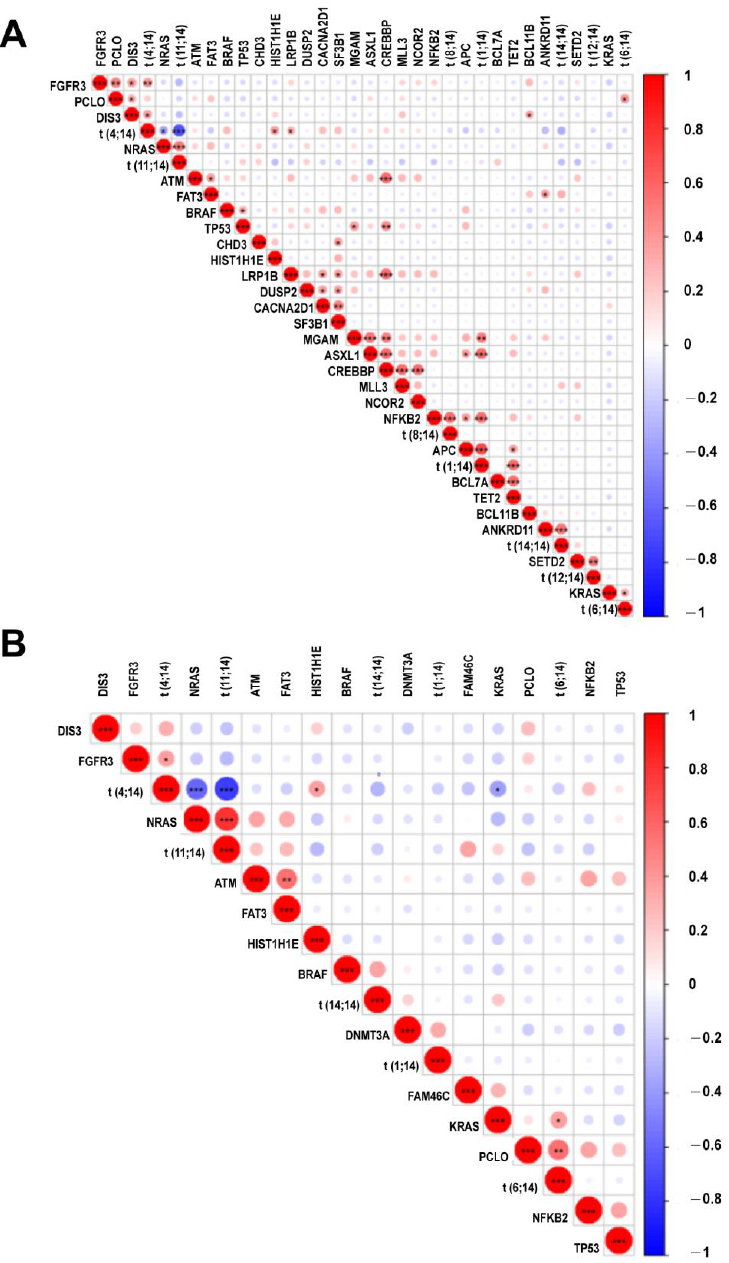
Figure 4. Correlation heatmap for hot somatic mutations and cytogenetic abnormalities. Correlation between mutations and recurrent cytogenetic abnormalities. Intensity of color shade represents the degree of correlation (blue, negative; red, positive) as per the scale. *, **, *** represent p value less than 0.05, 0.01, 0.001, respectively. ( A ) ctDNA; ( B ) BM. Multivariate Cox regression analysis showed that Age ≥ 65 y, DNA repair pathway mutation in ctDNA, and transcriptional regulation pathway mutation in ctDNA were independent risk factors to predict PFS, as shown in Figure 6G. Moreover, we used ROC analysis to determine the best value for ctDNA mTBI was 2.765% ( p = 0.015, sensitivity 68.9%, specificity 59.5%), and the uni- and multivariate Cox regression analysis for PFS was consistent with that grouping by the